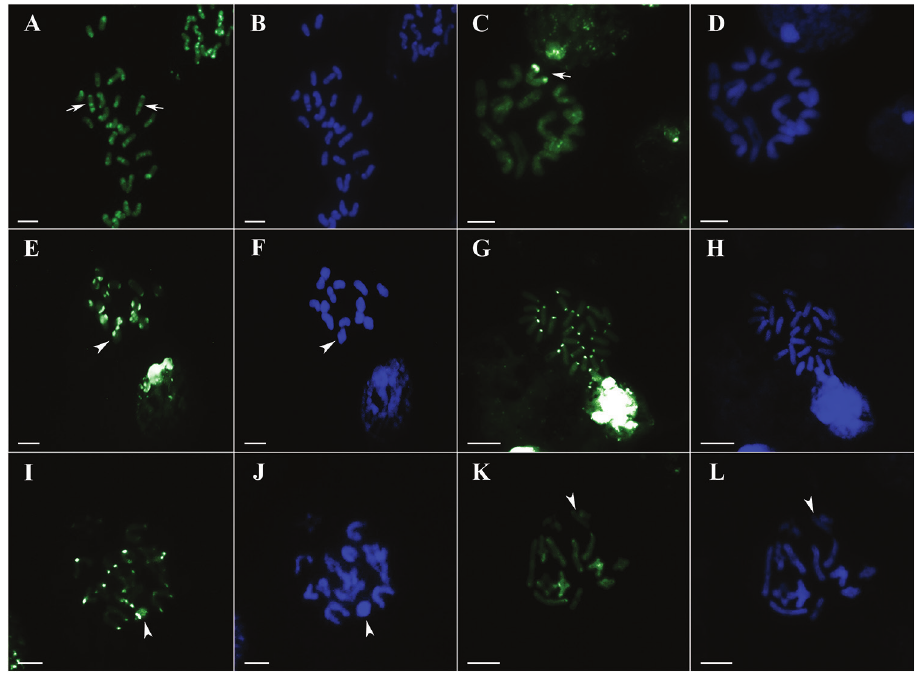
Figure 2. Ctenidae male mitotic and meiotic cells, C-banding and staining with base-specific fluoro- chromes CMA ( A, C, E, G, I, K ) and DAPI ( B, D, F, H, J, L ). Arrowhead - X chromosomes. A, B mi- 3 totic metaphase of Ctenus ornatus , 28 chromosomes, arrow – interstitial CMA 3+ region C, D diakinesis of C. ornatus , Ubatuba population, arrow – bivalent with large CMA 3+ block E, F diakinesis of C. medius G, H mitotic metaphase of Phoneutria nigriventer , 2n=28 I, J diakinesis of Viracucha andicola K, L diaki- nesis of Enoploctenus cyclothorax . Bar = 10